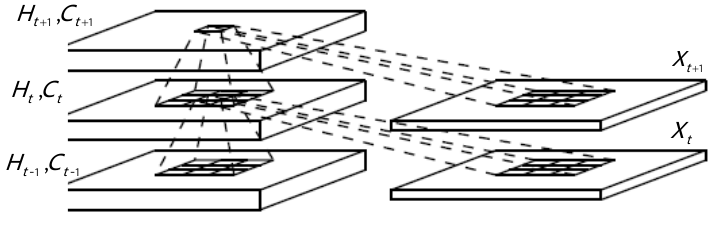
Figure 1. Inner structure of convolutional long short-term memory (ConvLSTM)